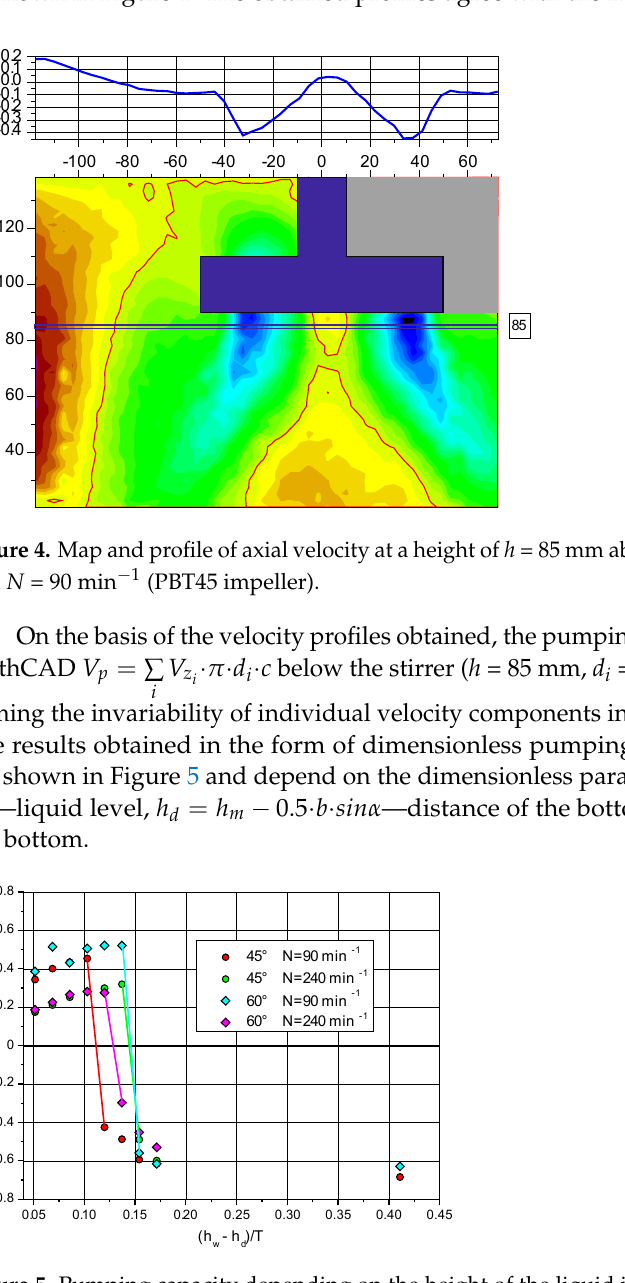
retical value of the pumping number can be determined by transforming the Equation (5).